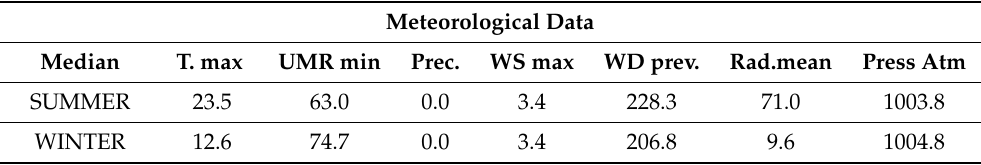
Table 1. Median of the meteorological variables used for modeling and measured across the entire analysis period, calculated separately for the summer and winter seasons. T. max: maximum temperature; UMR min: minimum relative humidity; Prec.: precipitation; WS max: maximum wind speed; WD prev.: prevailing wind direction sector; Rad.mean: mean global radiation; Press Atm: mean atmospheric